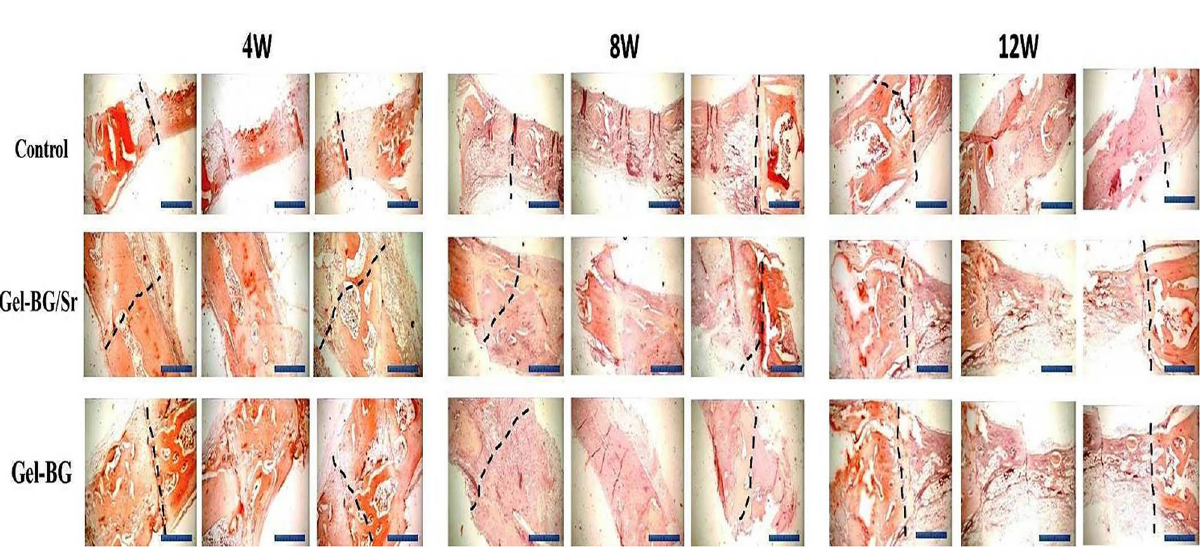
Figure 4. Histological examination (Trichorm-Masson staining) at 4, 8 and 12 weeks. IB; Intact Bone, NB; New Bone (magnification ×40).